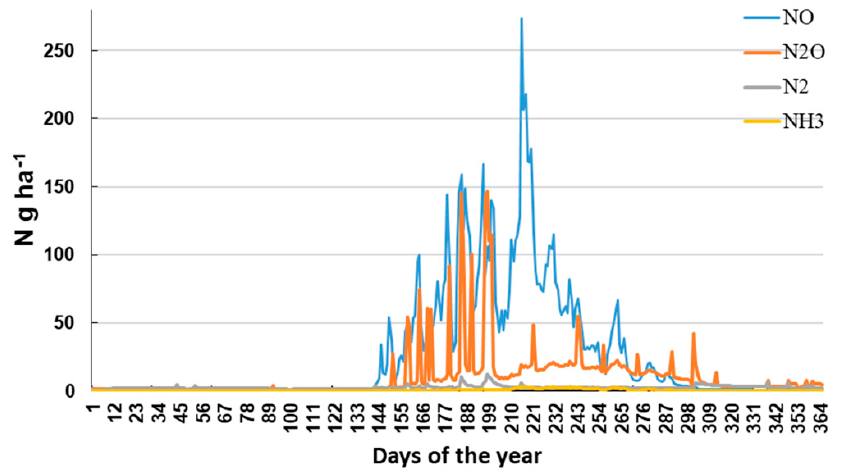
Figure 9. Modelled estimated N-fluxes (g N ha − 1 day − 1 ) of the Great Vasyugan Mire in 2019.